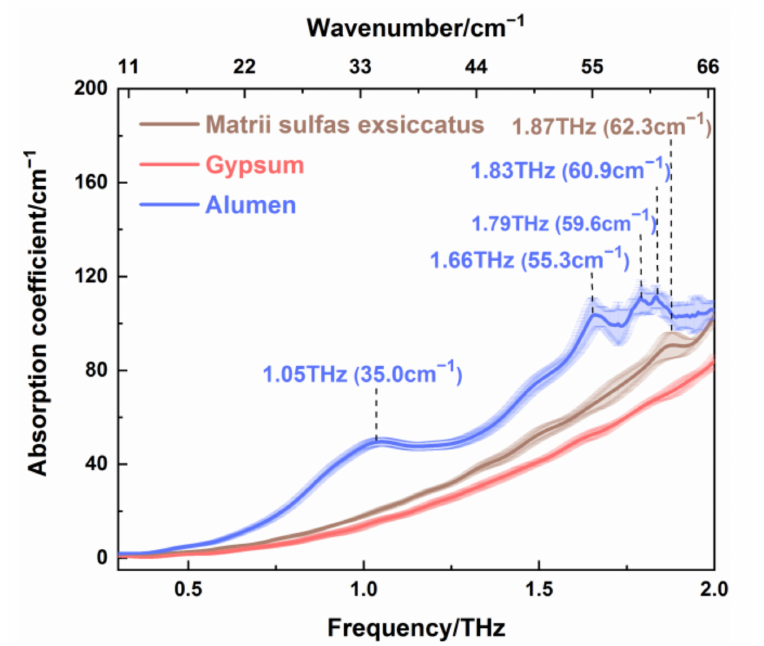
Figure 5. The THz absorption spectra of matrii sulfas exsiccatus, gypsum, and